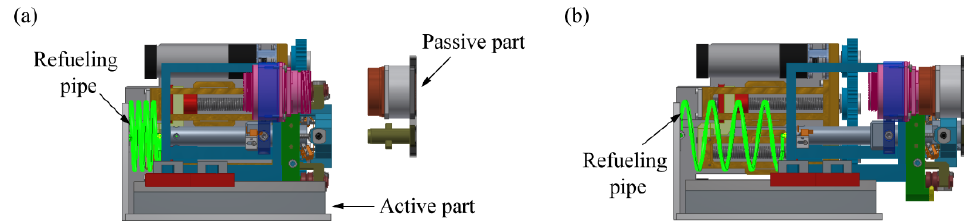
Figure 2. Stretching of a refueling pipe with a helical configuration: ( a ) initial state of compression, ( b ) terminal state of tension. ( b ) terminal state of